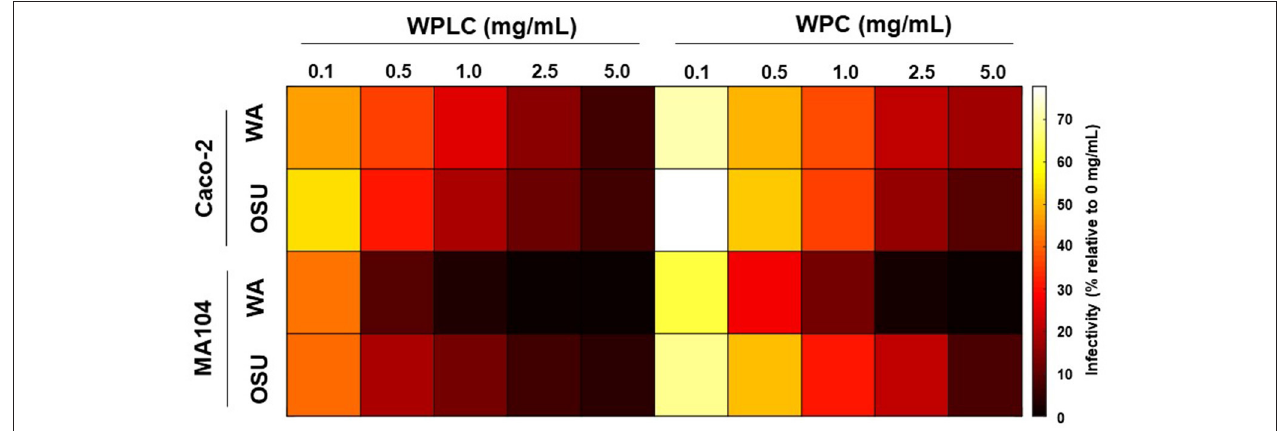
FIGURE 5 | Heatmap representing WPLC and WPC efficacy in reducing porcine OSU and human Wa RV infectivity in MA104 and Caco-2 cells at concentrations ranging from 0.1 to 5.0 mg/mL (data shown in Tables 1 , 2 ). Data are represented as % infectivity relative to control 0 mg/mL (scale on the right of the graph). Statistical analysis indicated independent and interactive effects ( p < 0.01) of cell type, RV strain, test material, concentration, cell type*RV strains, cell type*concentration, RV strain*concentration, cell type* RV strain*test material*concentration. The interaction of cell type*test material was significant at trend level ( p = 0.08), RV strain*test material was not statistically significant. RV, rotavirus; WPC, whey protein concentrate; WPLC, whey protein lipid